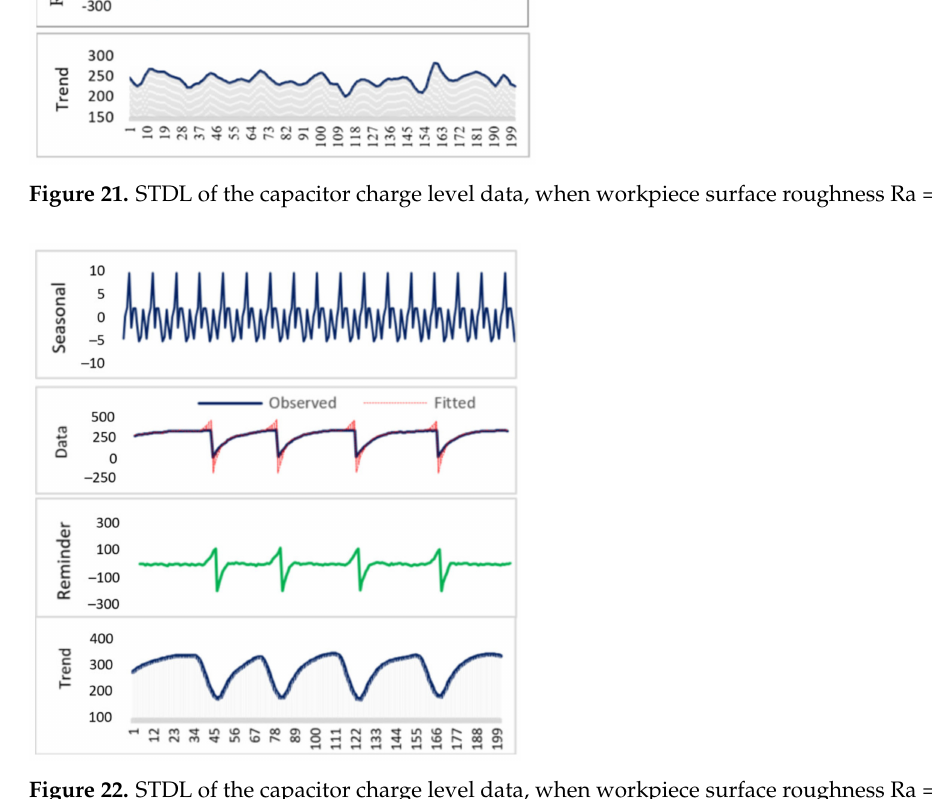
Figure 22. STDL of the capacitor charge level data, when workpiece surface roughness Ra =